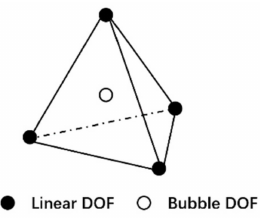
Figure 6. The mini tetrahedral element.